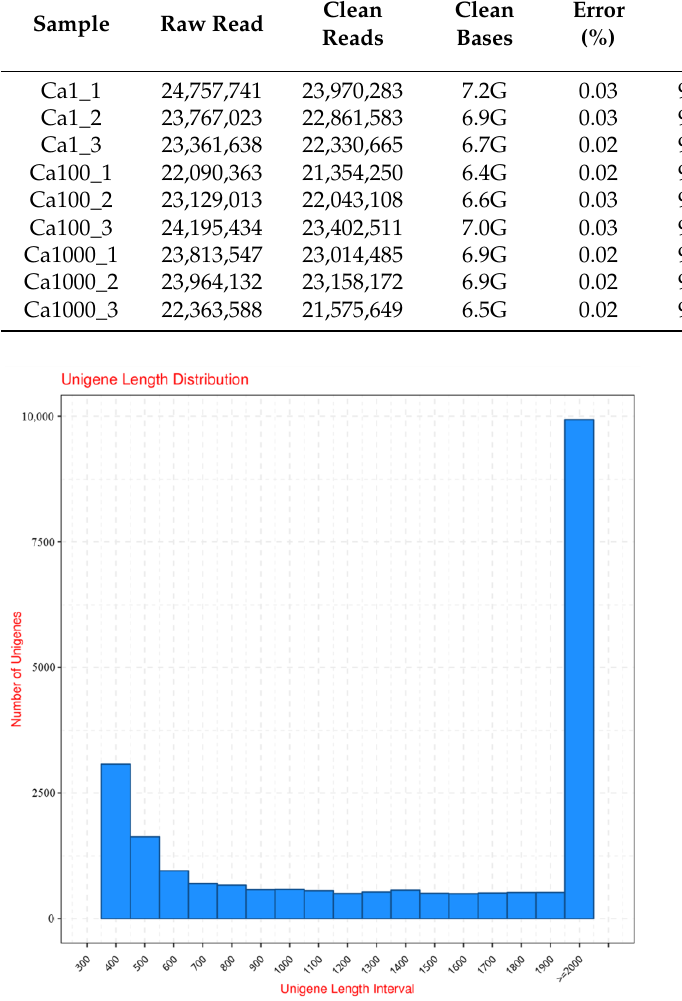
Table 1. Summary of Sequencing Data Quality of P. kessleri FACHB-3316.